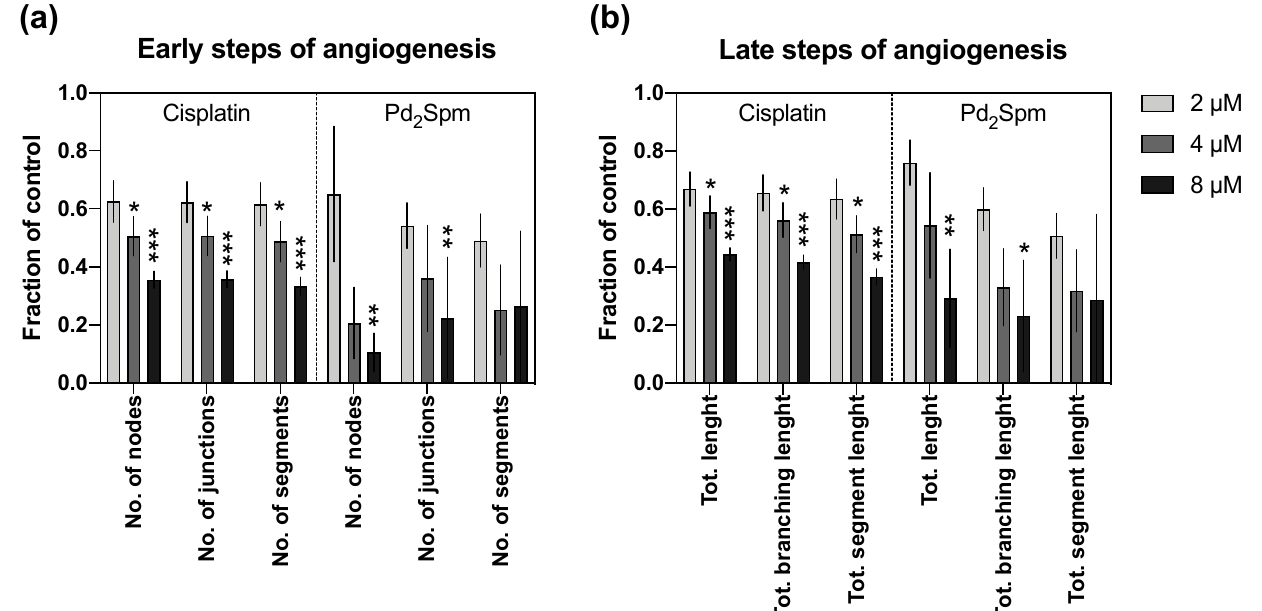
Figure 7. Quantitative results of CAM angiogenesis in the presence of increasing concentrations (2–8 µM) of either cisplatin or Pd 2 Spm. ( a ) Parameters of early steps of angiogenesis: number of nodes, junctions and segments. ( b ) Parameters of later steps of angiogenesis: total length, branching length and segment length of vessels. The results are expressed as means of the fraction of the control ± SEM from 2 independent experiments ( n = 2, 8 replicates). Significant differences from the vehicle control: * p < 0.05, ** p < 0.01, *** p < 0.001 (one-way ANOVA followed by Dunnett’s multiple comparison test).